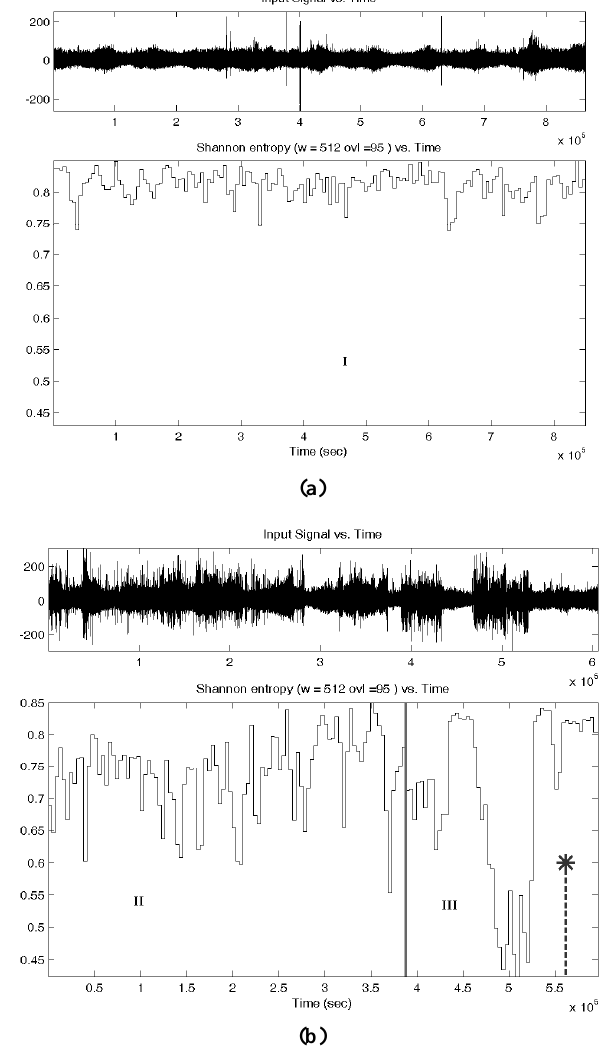
Fig. 3. Fisher information evolution with time (a) for epoch I, and (b) for the epochs II and III of the signal of Fig. 2. The original EM signal is processed beforehand by running difference. As a result, the first difference time series is analyzed. The analyzed signal is given on top of the resulted Fisher information temporal evolution, time aligned for direct reference. We observe a gradual increase of the Fisher information as the EQ approaches, indicating an increase of the organization of the underlying process.